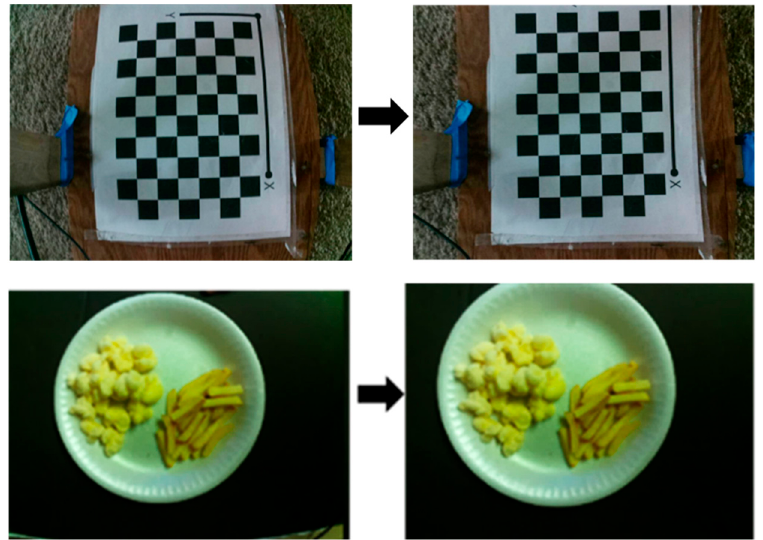
Figure 2. Camera lens distortion correction. The distortion coefficients are calculated using the checkerboard images. The figure indicates before and after images of the correction model.